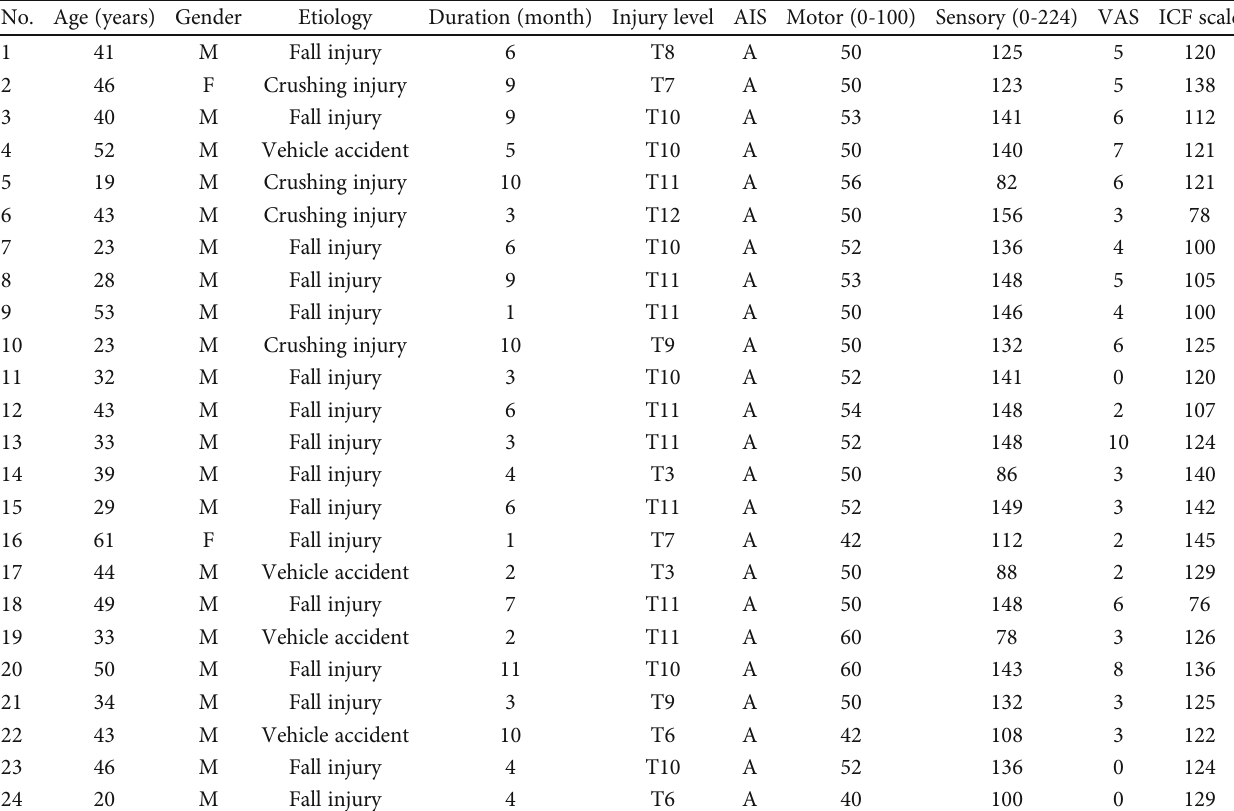
Table 1: Demographic characteristics and clinical variables of the spinal cord injury patients.